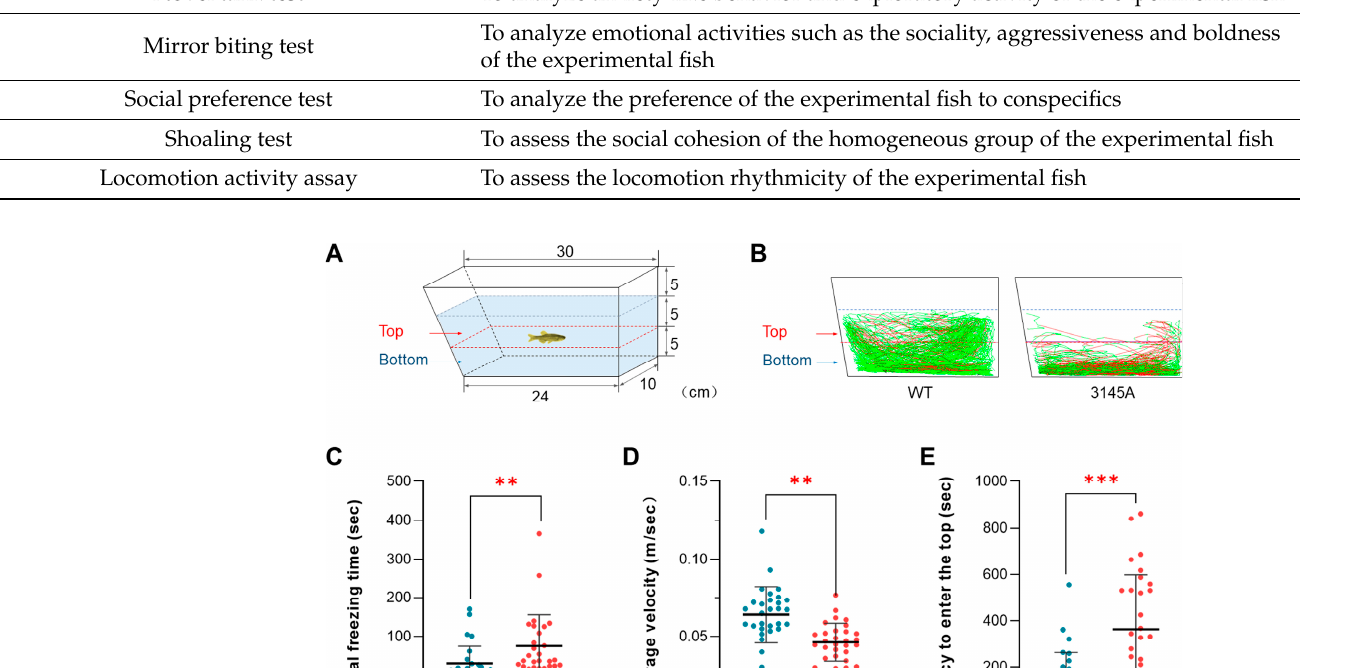
Table 1. A list of the behavioral assays and the purposes.